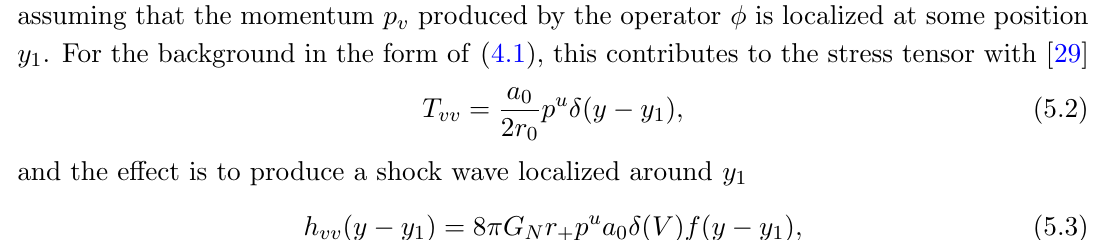
Figure 12 . Bound on information given by N send . a v tum. Fixed temperature T = 1